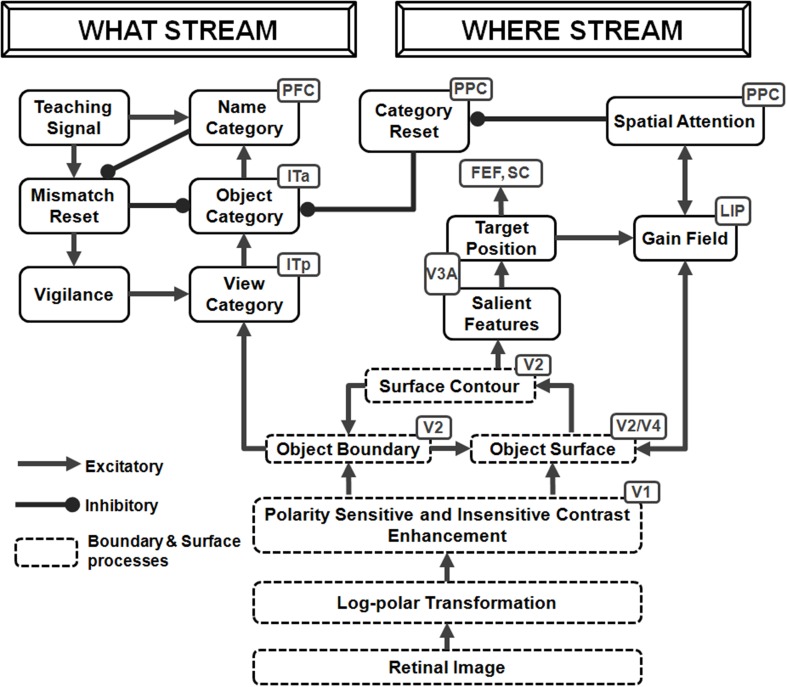
Model diagram of the ARTSCAN model (reprinted with permission from Chang et al., 2014). A few simplified stages from the FACADE model (Grossberg and Todorović, 1988; Grossberg, 1994, 1997; Grossberg and McLoughlin, 1997) preprocess 2D images. The 3D ARTSCAN model is a synthesis and further development of the ARTSCAN model, the aFILM model of anchored lightness and color perception (Hong and Grossberg, 2004; Grossberg and Hong, 2006), and the FACADE model to enable 3D surface percepts to remain stable as saccadic eye movements scan a scene (as elaborated in Figures 2–5).